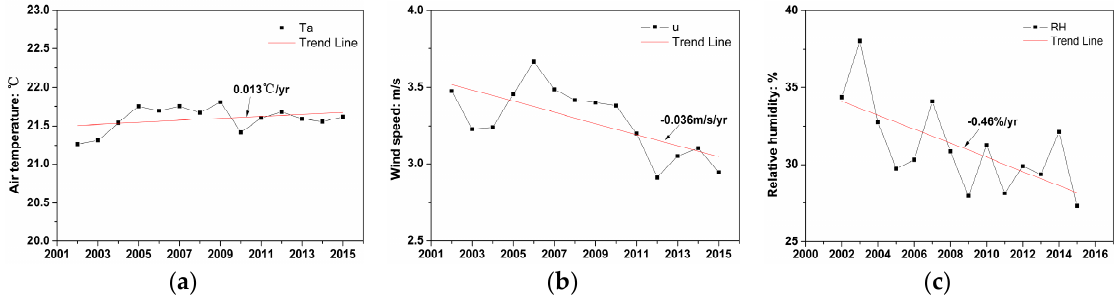
Figure 6. Correlativity of synoptic data between EJL and Ejina station. ( a ) T a ; ( b ) u ; ( c ) RH .